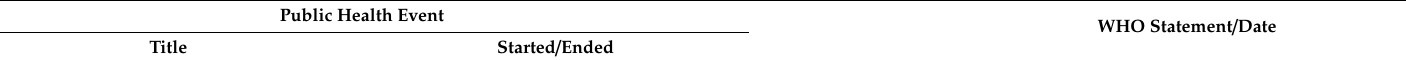
Table A2. WHO Temporary recommendations for PHEIC and advice for response measures to other